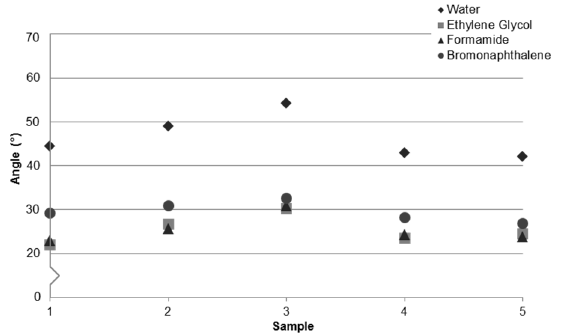
Figure 1. Contact angles on APEX glass samples. Each data point represents the average value of measurements from 18 droplets. Measurement error ranged from ±0.07° to ±1.70° and averaged ±0.37°.